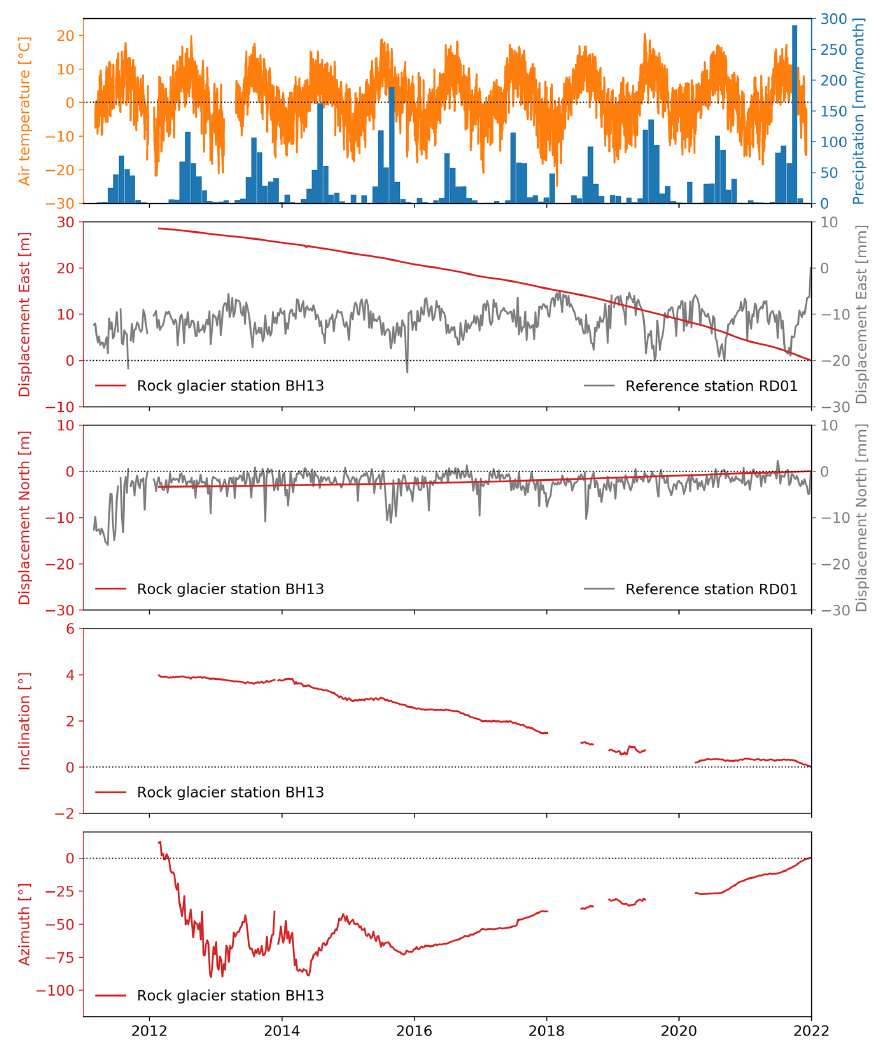
Figure 4. A decade of air temperature and precipitation from weather station DH13, as well as displacement, inclination, and azimuth for Gugla Bielzug Rock Glacier (position BH13) and displacements for reference station RD01.